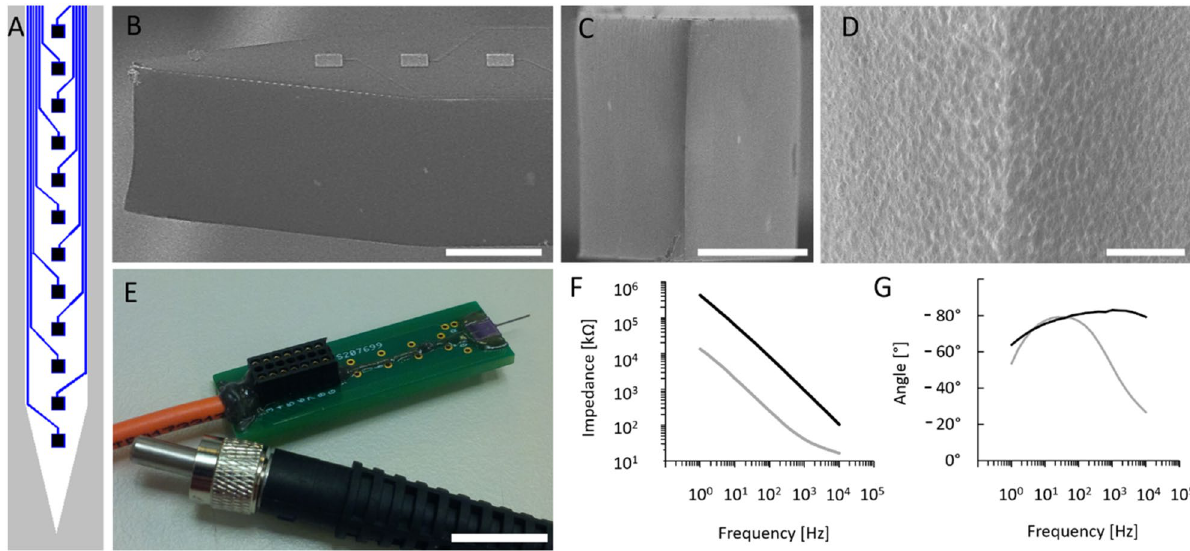
Figure 1. Topology of the linear array of recording sites along the probe shaft ( A ). Scanning electron microscopy images on the probe tip: sideview ( B ), front view ( C ) and close view ( D ) showing surface quality of the outcoupling region of the optrode chip. Assembled stimulation device ( E ). Representative Bode plot showing the impedance magnitude ( F ) and phase ( G ) with respect to frequency. Black line shows the initial condition after the micromachining processes have been finished, and the grey line shows the final condition after electrodeposition of porous platinum is completed. Scale bars represent 100 µm on ( B ) and ( C ), 30 µm on ( D ) and 10 mm on ( E ).